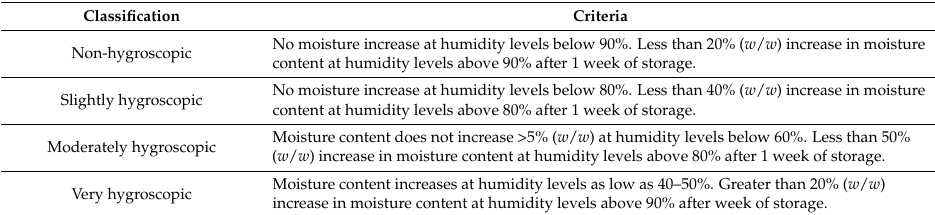
Table 2. Hygroscopicity classification [28].